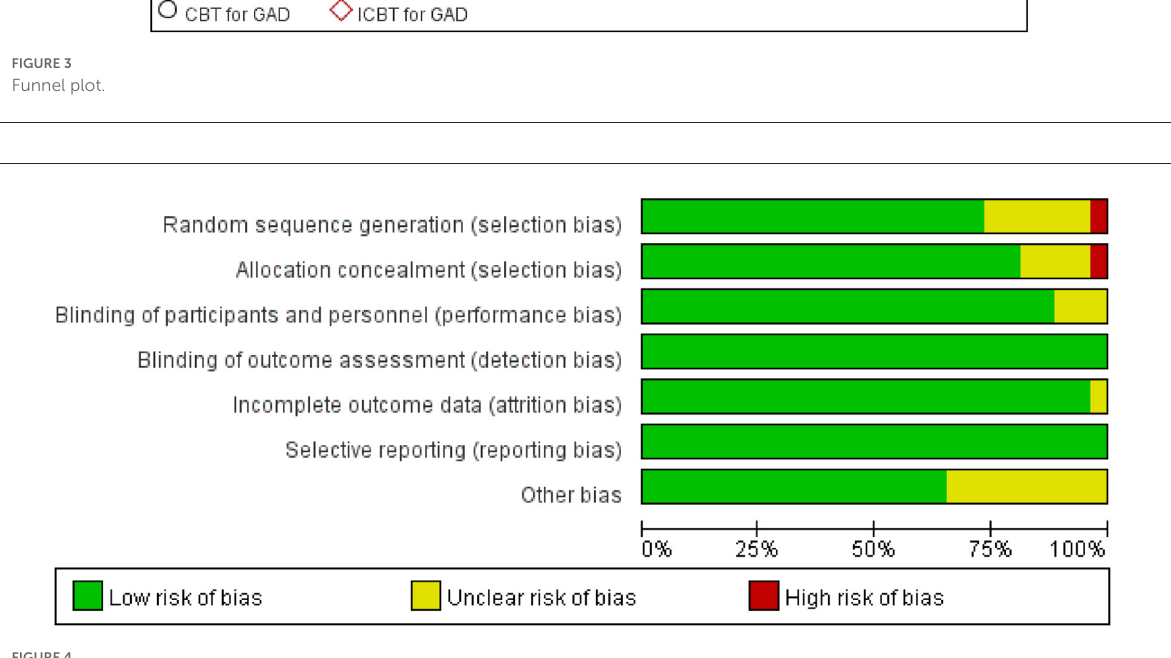
FIGURE3 Funnel plot.